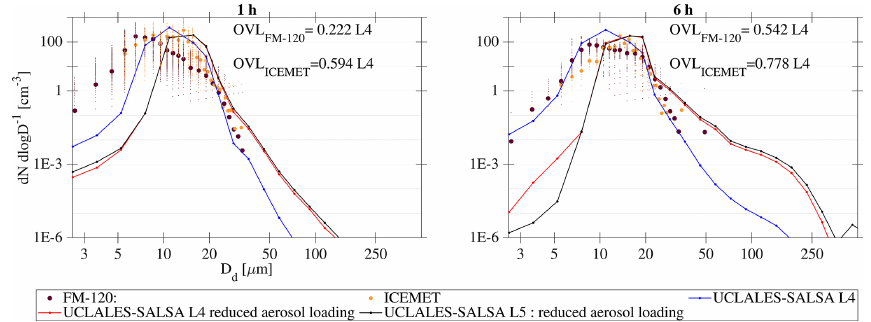
Figure 14. Modelled droplet size distributions at Puijo altitude of 225m for case 2, 31 October 2020, compared to observations from the fog monitor and the holographic imaging system. Overlapping index values (OVLs) are included as indicators of agreement between distributions.